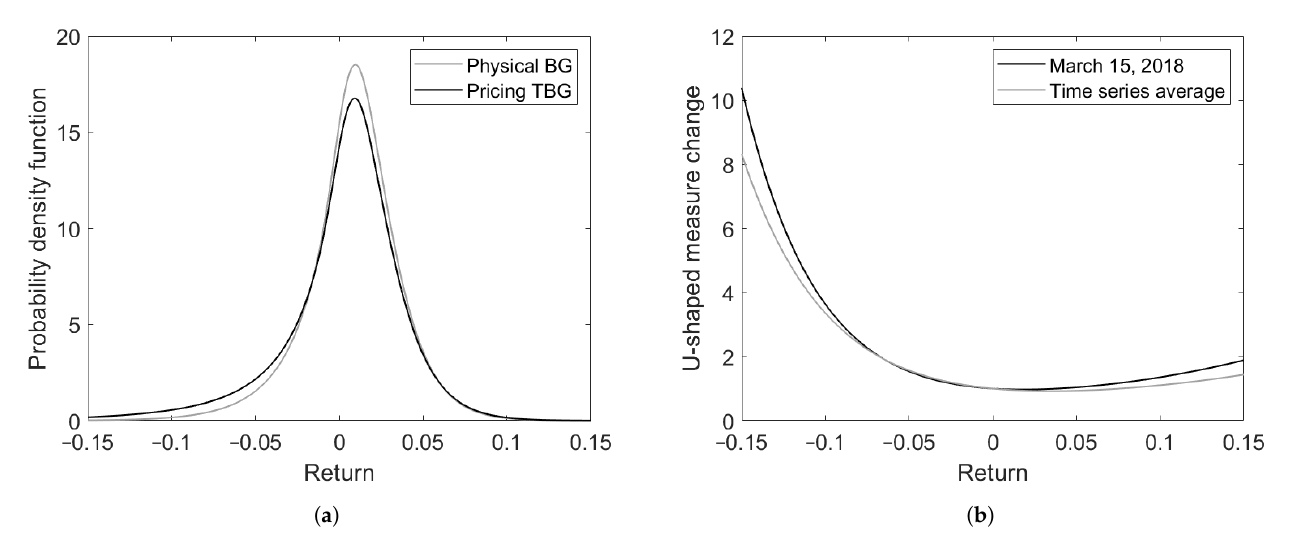
Figure 3. ( a ) Bilateral Gamma physical density and Tilted Bilateral Gamma pricing density of the one-month ahead S&P500 index return, on 15 March 2018. ( b ) Calibrated U-shape of the pricing kernel on 15 March 2018 together with a time series average U-shape based on the mean parameter values across all calibration dates. ( a ) Pdf; ( b ) U-shape.